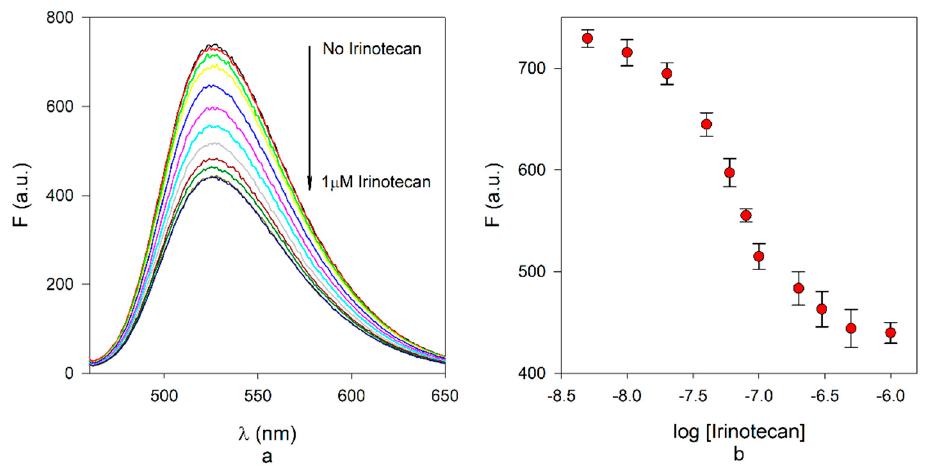
Figure 5. ( a ) Emission spectra of 60 μ g/mL MIP F at increasing concentrations of irinotecan in 3:1 acetonitrile:water (excitation 448 nm); ( b ) fluorescence decrease at 525 nm of 60 μ g/mL MIP F at increasing concentration of irinotecan in 3:1 acetonitrile:water.